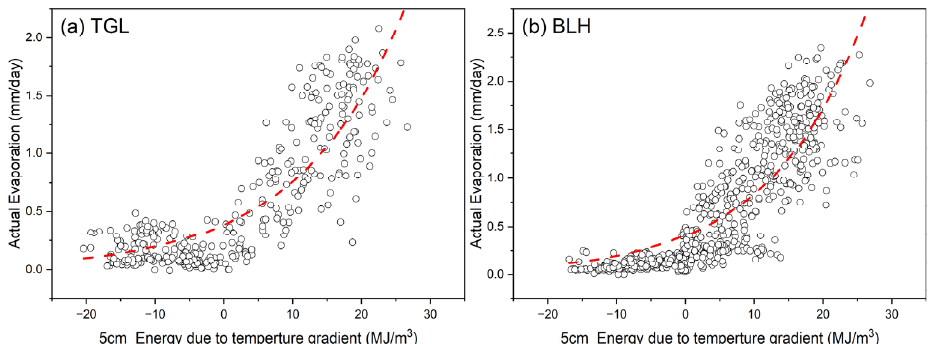
Figure 10. The energy due to the temperature gradient in 5 cm thickness of soil ( Q t_ 5cm ) effects on the diurnal variation of actual evaporation ( p < 0.05).